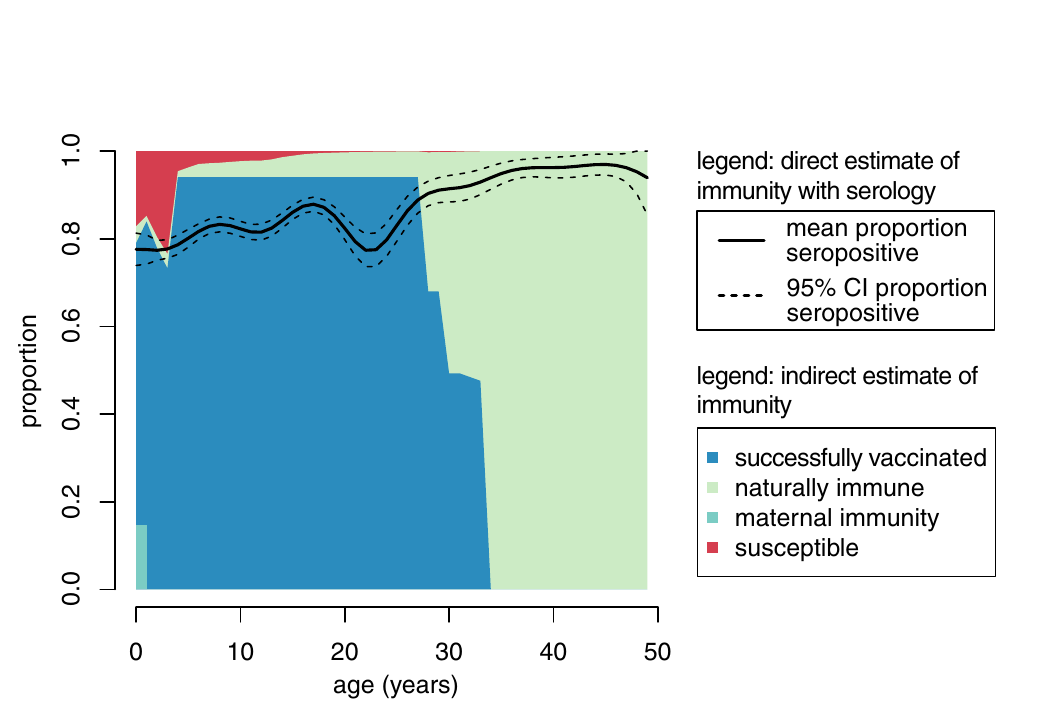
Figure 3. Comparison of two estimates of national age-specific measles immunity profiles. The direct estimate, based on generalized additive models fit to the seroprevalence data, is represented as the solid (mean) and dashed (95% CI) lines. The indirect estimate is based on a birth-cohort method that estimates immunity per birth cohort. Each birth cohort has a unique probability of being successfully vaccinated (dark blue), a probability of being infected (light green), and among infants a probability of being immune through maternally-acquired antibodies (teal). The proportion of the population each age that remains susceptible is shown in